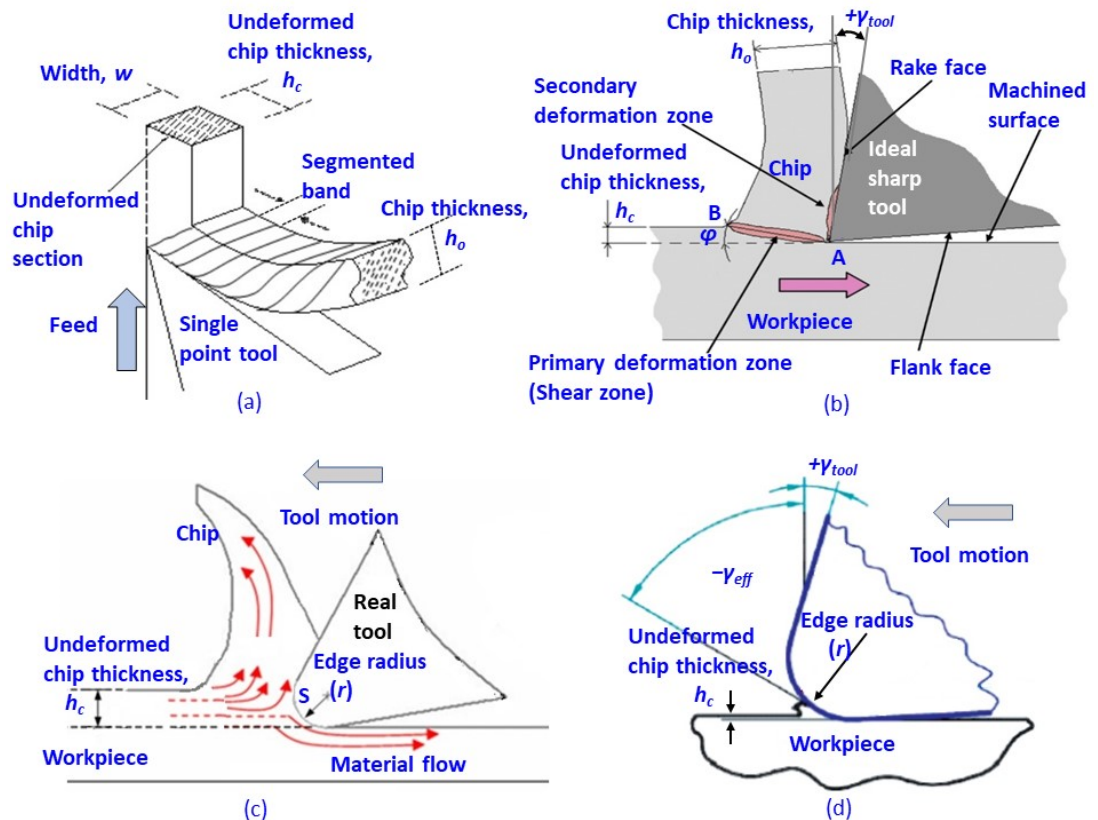
Figure 1. Schematic of ( a ) 3D view of orthogonal cutting with single-point cutting tool [28] ( b ) 2D view of macro machining model [29] ( c ) 2D view of micromachining model [30] ( d ) 2D view of ploughing in micromachining [33]. Copyright Permission obtained.